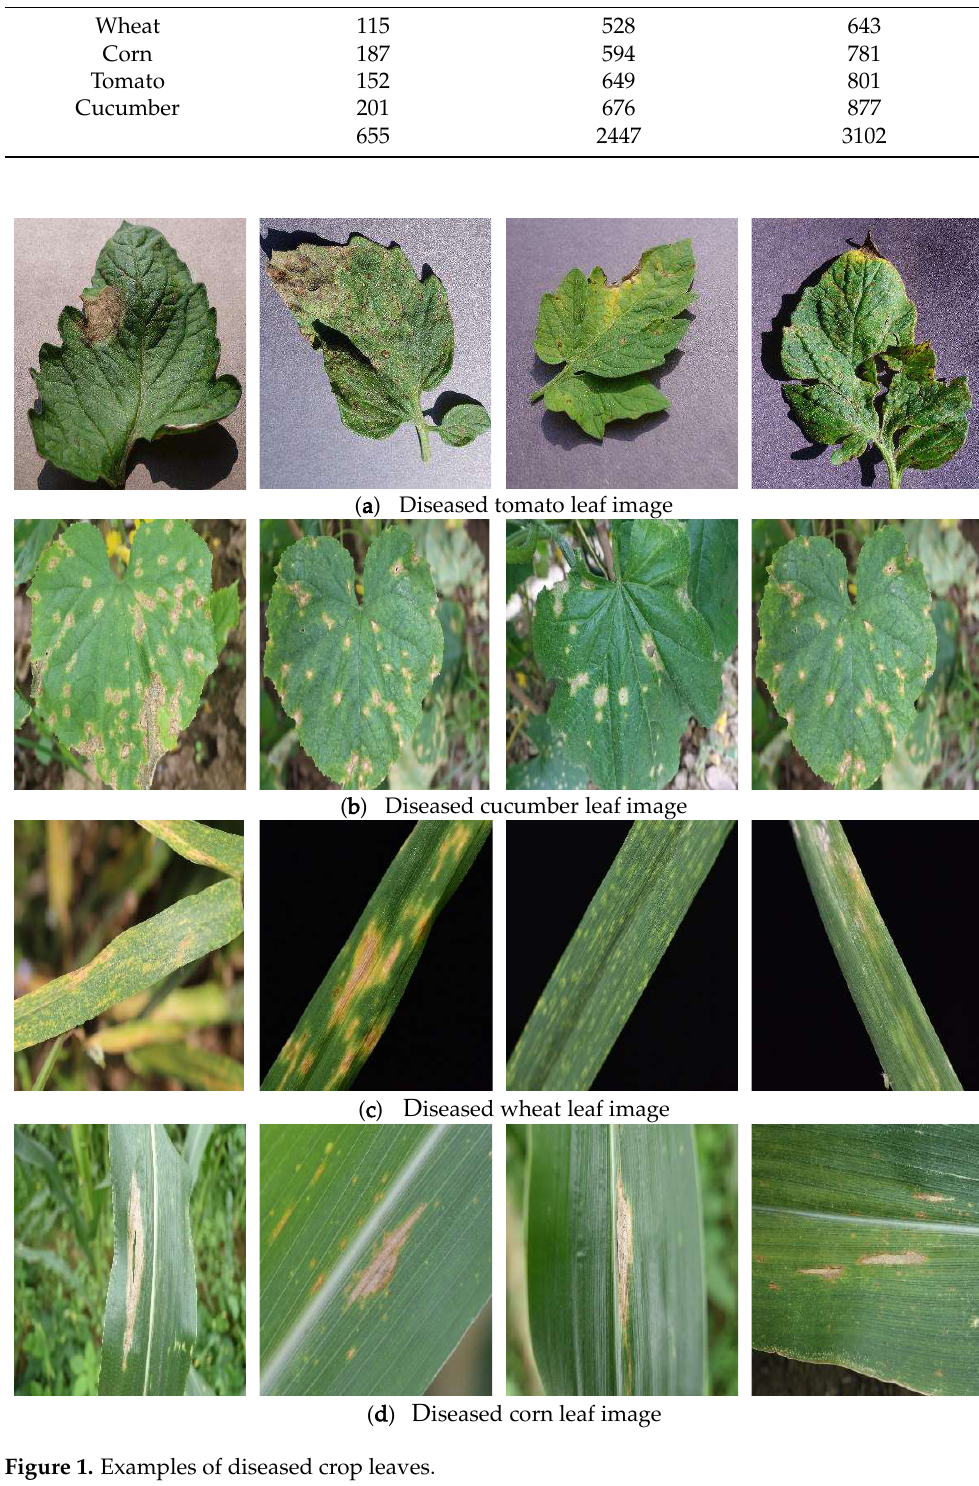
Figure 1. Examples of diseased crop